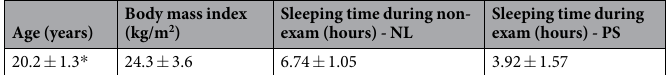
Table 1. Baseline features of the 25 participating male students. * Mean ±